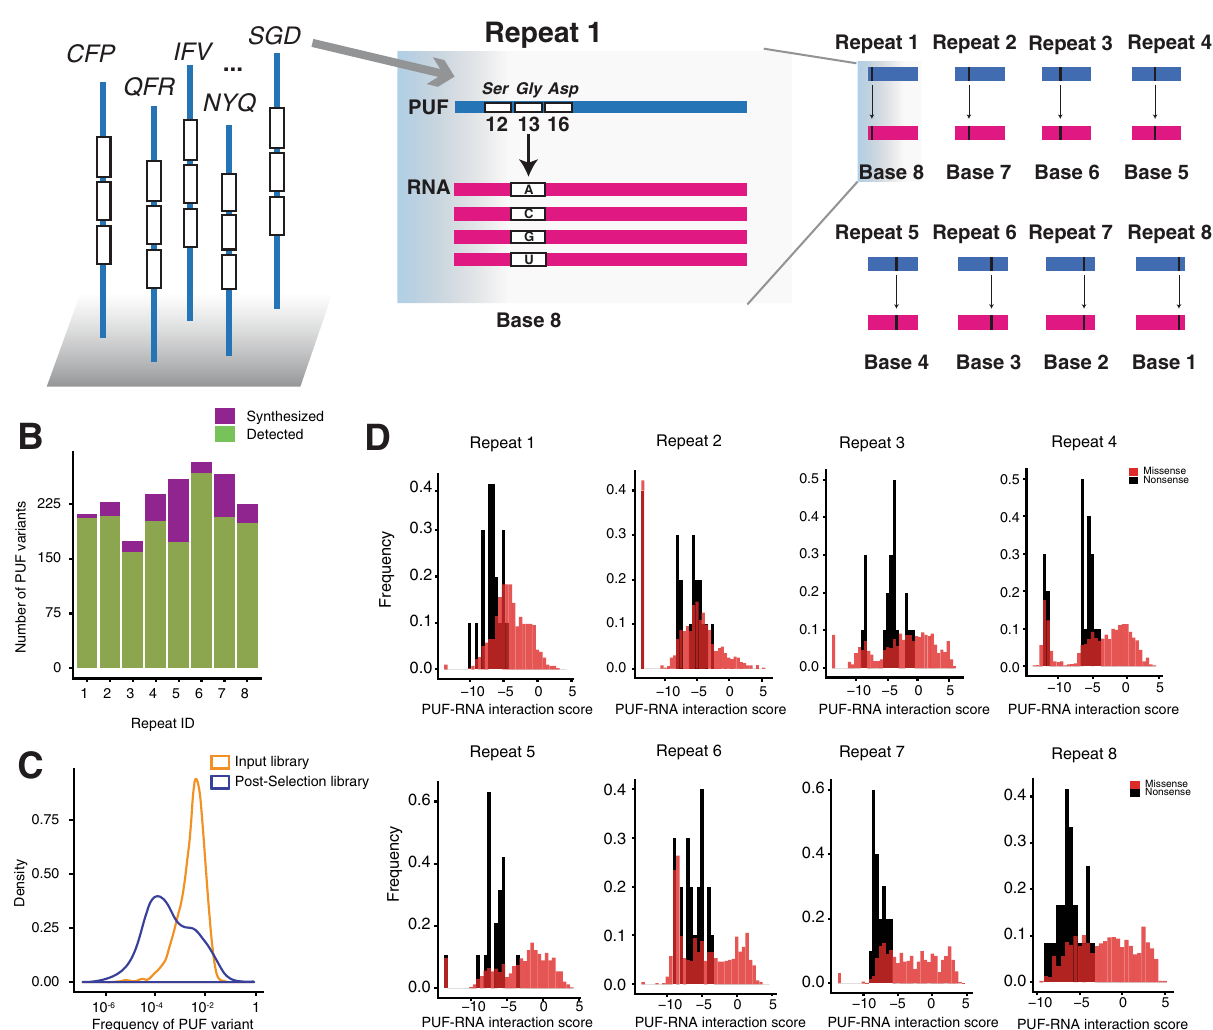
Fig. 2 Targeted screening of candidate PUF variants. A Work fl ow for the targeted screening experiment. The left panel shows examples of oligos designed for synthesis; the middle panel shows one example incorporated into the library repeat 1; the right panel shows a schematic of incorporation at all repeat locations. B A bar plot showing the fraction of targeted PUF variants recovered in each repeat. Purple indicates the number of synthesized PUF variants and green indicates the number of recovered PUF variants in each repeat. C A density plot showing the frequency of PUF variants in input and selected pool. Yellow indicates input library and blue indicates post-selection library. D The frequency distribution of nonsense and missense PUF variants for all repeat locations. The X -axis is a measure of PUF-RNA interaction score. Black indicates nonsense variants and red indicates missense